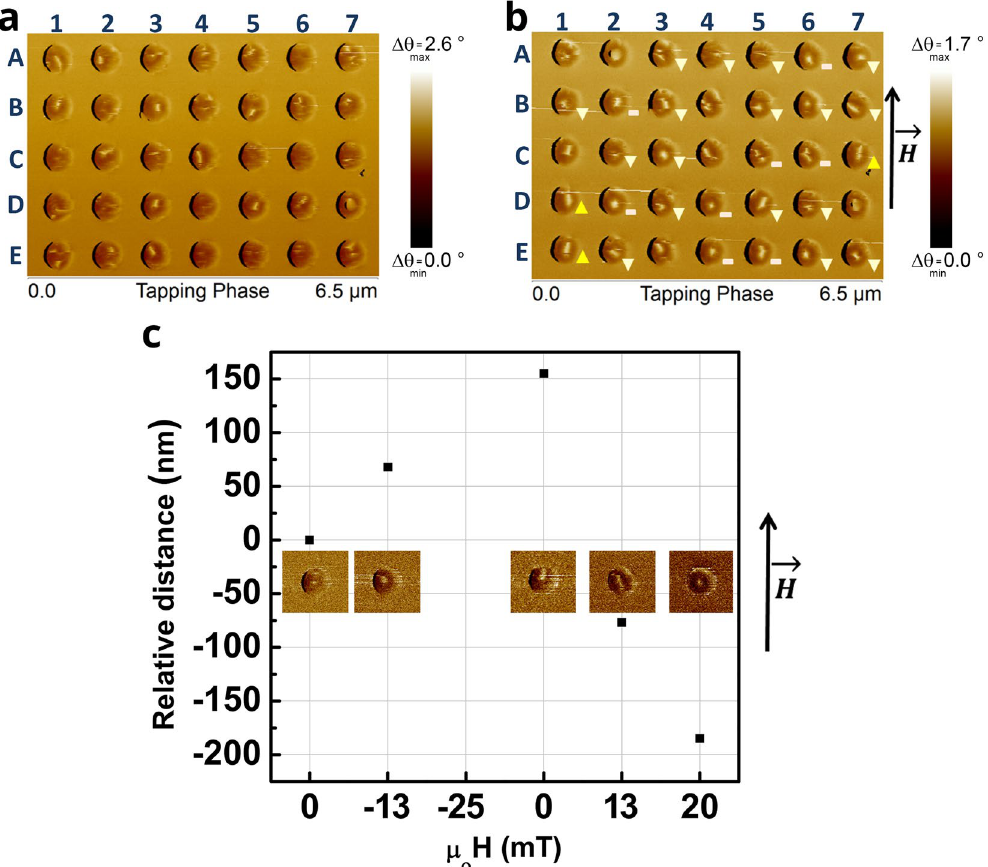
Figure 5. MFM images of 300 nm diameter disks sample type 15FP-AI under different conditions. ( a , b ) 3 T out-of-plane field and ( c ) − 4 T out-of-plane field, both following an AC demagnetization process with a maximum 1 T in-plane field. The response to the external field is highlighted such that an upward or downward motion is indicated by triangles, appearance of the dots in disks after field application is denoted by a – sign. ( c ) Motion under different in-plane magnetic fields. Relative displacement versus applied in-plane